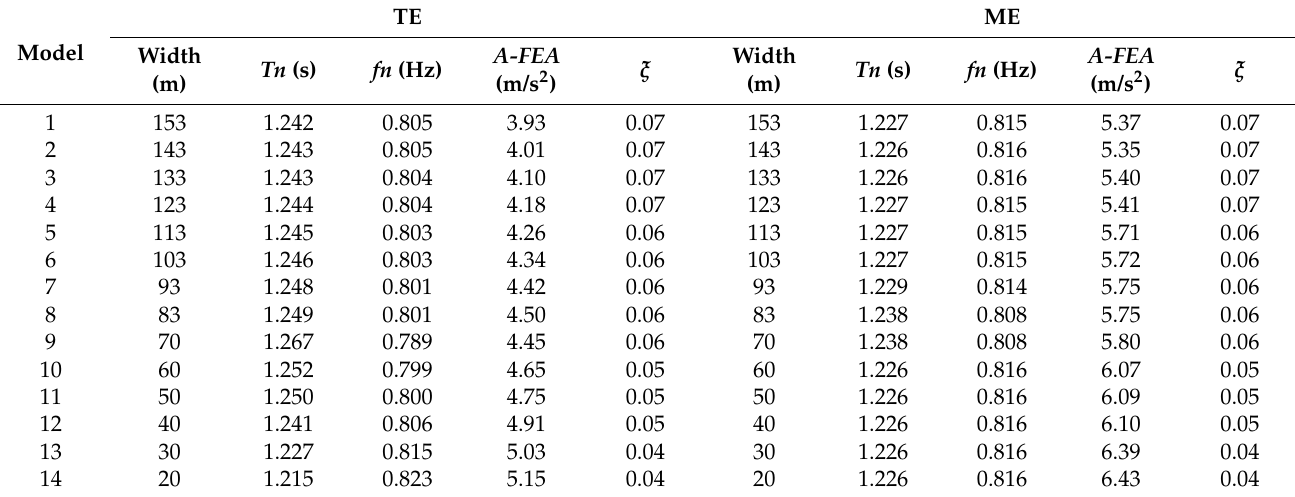
Table 4. FEA results for Scenario 1.